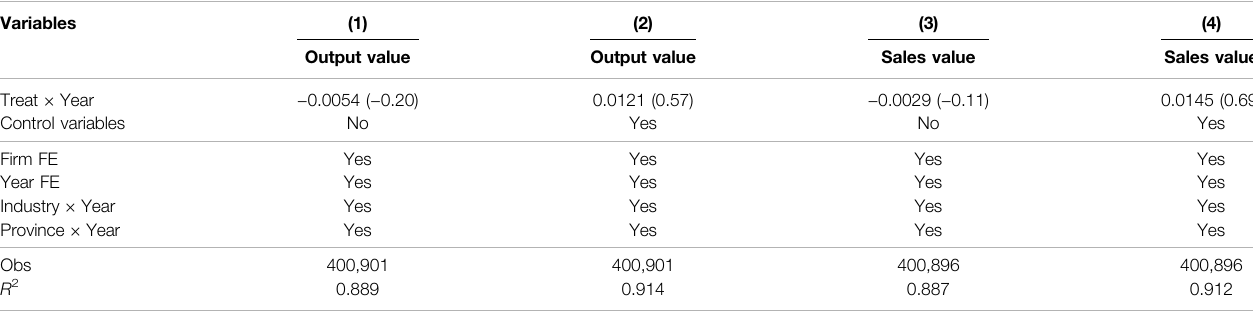
TABLE 14 | Results of the mechanism of production scale